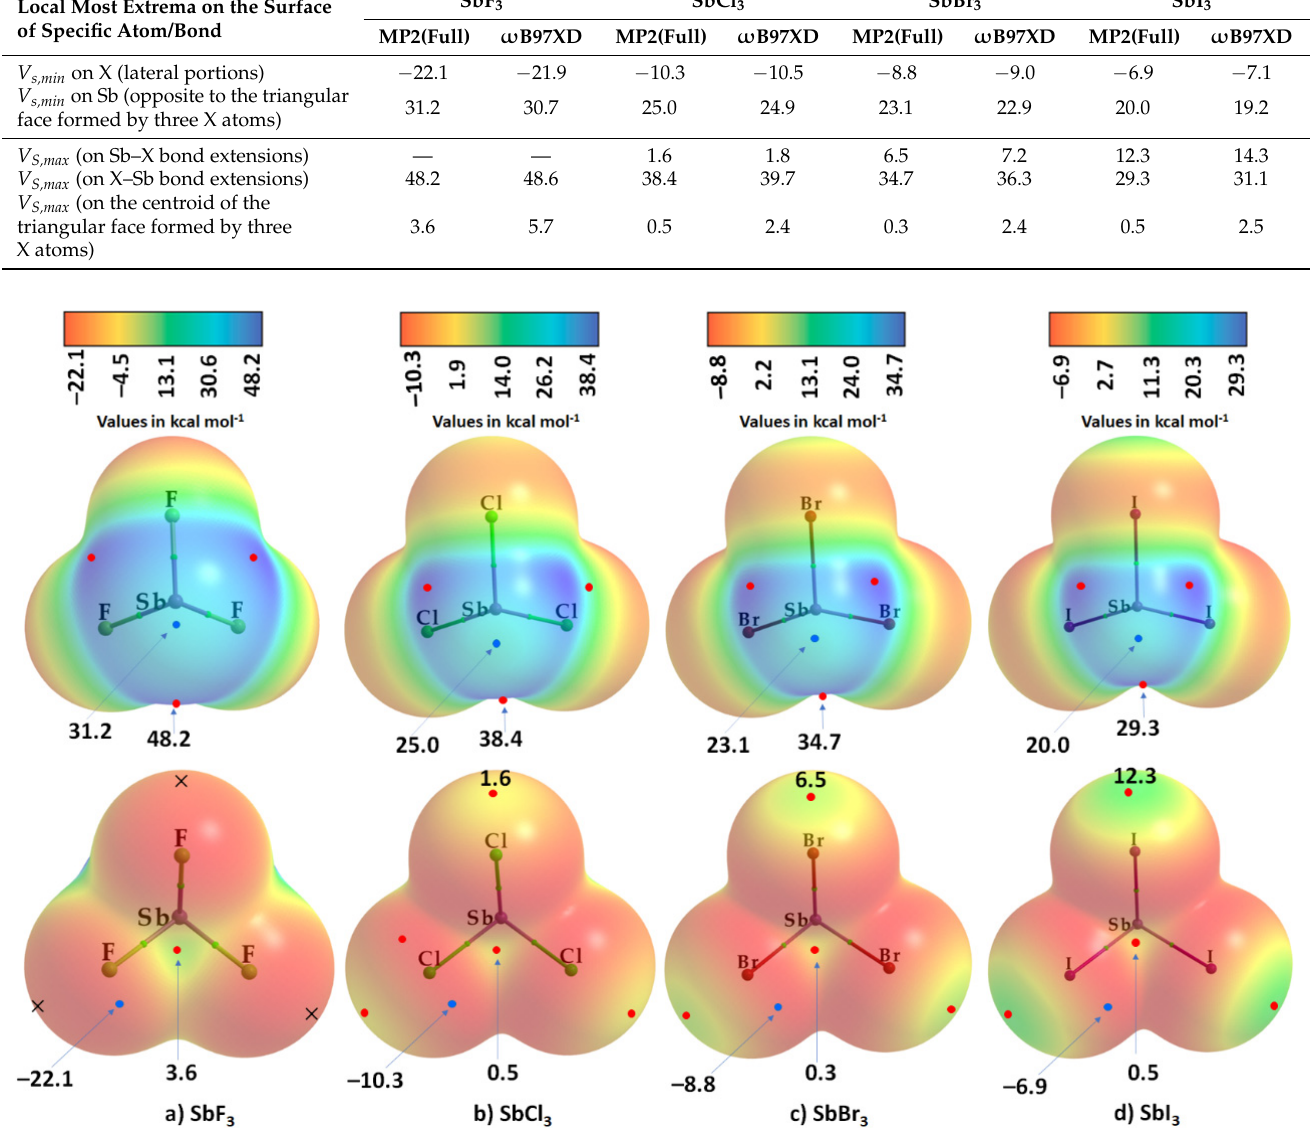
Figure 2. MP2(full)/def2-TZVPPD calculated 0.001 a.u. isoelectron density mapped potential on the electrostatic surfaces of SbX 3 (X = F, Cl, Br, I) molecules: ( a ) SbF 3 ; ( b ) SbCl 3 ; ( c ) SbBr 3 ; ( d ) SbI 3 . Selected V S,max and V S,min values in kcal mol − 1 are shown, which are the local most minimum and maximum of potential (tiny circles in blue and red), respectively. Two views of the MESP graph for each molecule are displayed. ( Top ): Covalently bound Sb faces the reader. ( Bottom ): The triangularly arrayed X atoms face the reader. The crosses ( × ) shown along the extensions of the Sb–F bonds highlight the absence of a σ -hole on F, indicating that F is entirely negative. Table 2. Comparison of MP2(full)/def2-TZVPPD level 0.001 a.u. isodensity envelope mapped po- Based on a simple Lewis model, SbX 3 should be a C 3 v molecule with a lone pair at tentials with those of ω B97XD/def2-TZVPPD potentials computed on the surfaces of the SbX 3 mol- the apex of the pyramid. The ground state electronic configuration of Sb 3+ is [Kr] 4d 10 5s 2 . ecules (X = F, Cl, Br, I). Despite the (formal) localization of the lone pair in an s orbital, the lone pair in many Sb 3+ compounds is stereochemically active. For example, the gas phase structure of SbCl 3 is trigonal pyramidal (approximately C 3v ) as determined by gas-electron diffraction with a Cl–Sb–Cl angle of 97.2(9) ◦ [120], in agreement with the rotational constants obtained